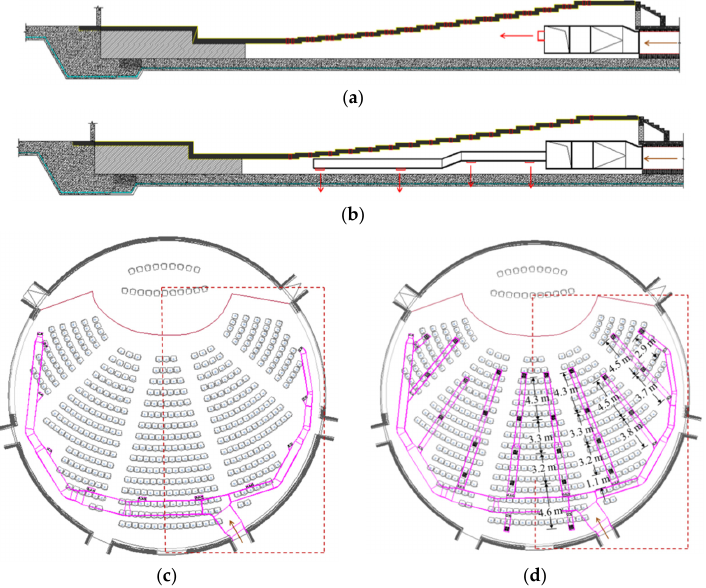
Figure 2. Schematic diagram of the UFAD system. ( a ) vertical section of plenum under centralized air supply, ( b ) vertical section of plenum under uniform air supply, ( c ) layout of centralized air supply, and ( d ) layout of uniform air supply (dashed box represents the simulated zone).